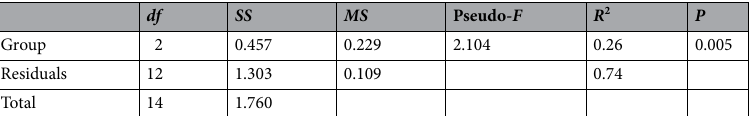
Table 1. Permutational multivariate analysis of variance (PERMANOVA) of endophytic bacterial communities (Operational Taxonomic Units—OTUs, presence/absence data) in three groups of samples: leaves from the model tree species Rhaphithamnus spinosus , leaves from the twining vine Boquila trifoliolata actually mimicking the tree leaves, and Boquila leaves from the same individual vine but not mimicking the tree leaves ( n = 5 replicates per group).